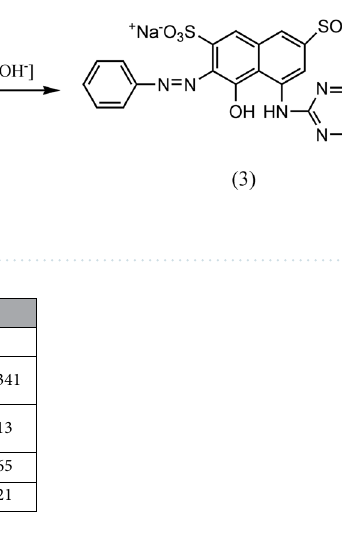
Table 2. Hydrolyzed velocity and velocity constant of Red 2 dye at varying pH conditions.